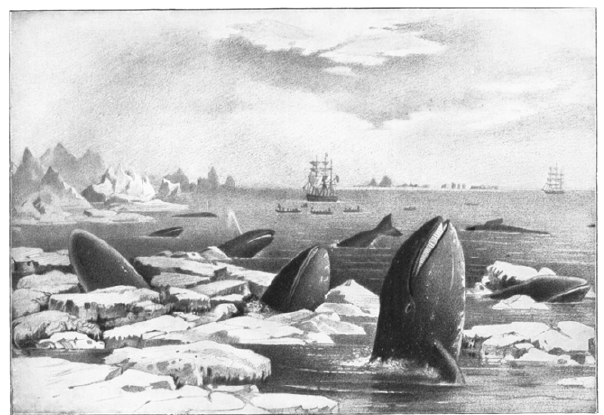
Figure 4. Gray whales amidst ice in the eastern North Pacific Ocean. Taken as anecdotal evidence, this illustration, reproduced from [25], provides insight into gray whale behavioral plasticity, especially in the presence of sea and pack ice. Several observations (e.g., [59]) suggest that gray whales possess a latent ability to tolerate ice, which would be a beneficial trait during episodes of glacial